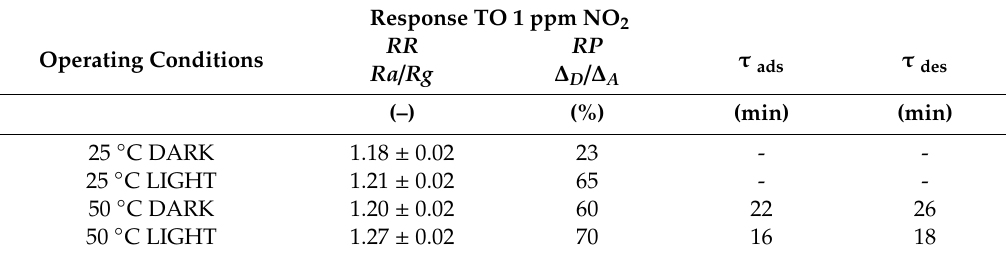
Table 1. Comparison of RR , RP , τ ads and τ des to to 1 ppm NO 2 in dark conditions and PB